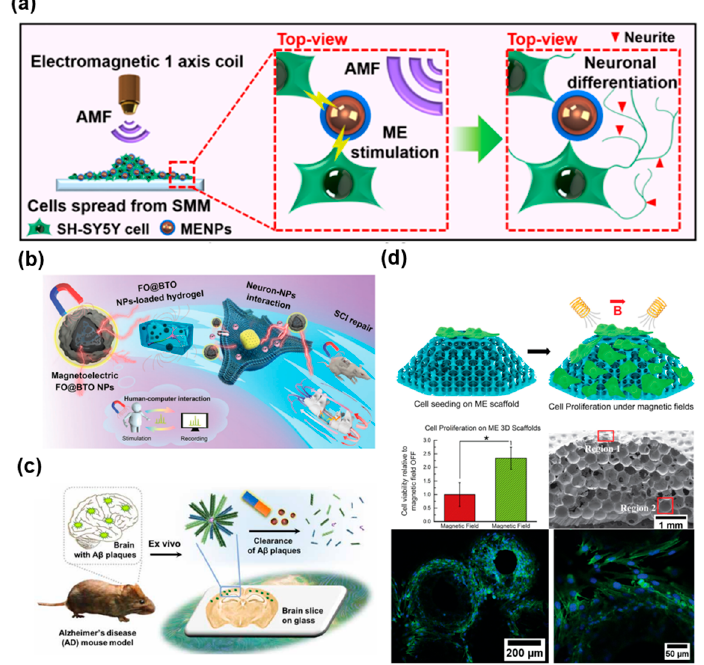
Figure 8. Cell regeneration induced by the ME effect of MENPs. ( a ) Schematic showing enhanced cell differentiation of SH-SY5Y cells through ME stimulation using MENPs. Reproduced with permission from [45]. Copyright 2022, Royal Society of Chemistry. ( b ) Repair of a spinal cord injury due to cell proliferation enhanced by ME stimulation of MENPs. Reproduced with permission from [77]. Copyright 2021, Wiley-VCH. ( c ) Clearance of A β plaques, the main indicator of Alzheimer’s disease, due to the ME stimulation of MENPs. Reproduced with the permission of [59]. Copyright